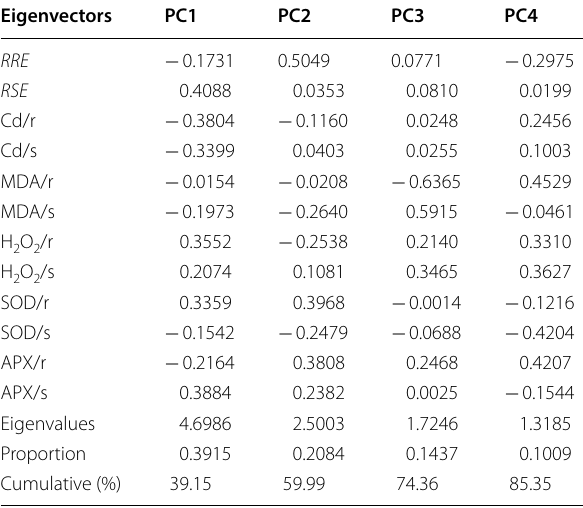
Table 1 Eigenvectors and eigenvalues for the principal components (PC1, PC2, PC3, and PC4) derived from the variants: RRE , RSE , Cd concentrations in root and shoot (Cd/r and Cd/s), and relative MDA, H and APX in root and shoot (MDA/r, MDA/s, H SOD/r, SOD/s, APX/r, and APX/s)